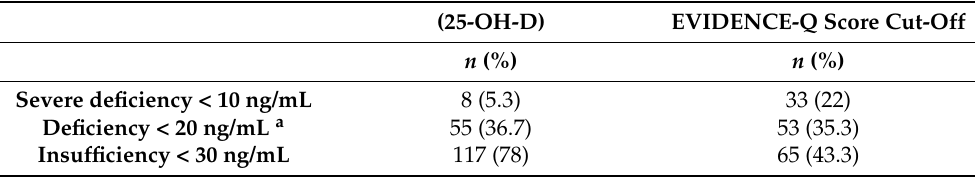
Table 4. Prevalence